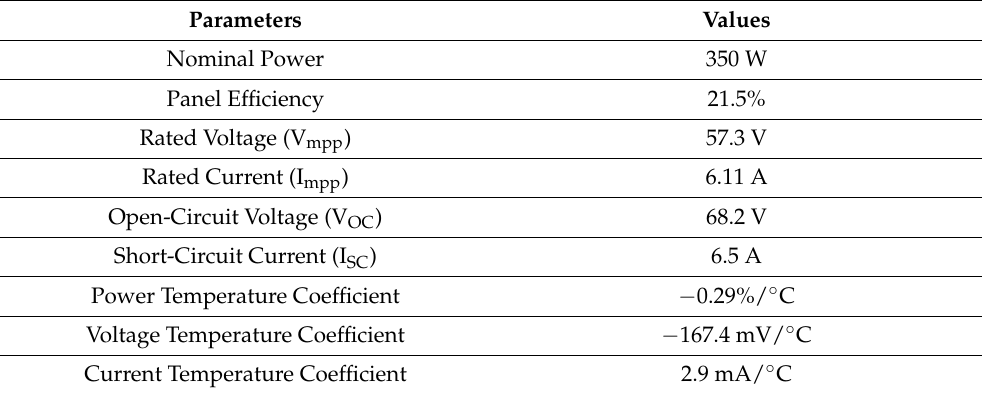
Figure 5. The PV installation site with a 0.99 MW PV installation located at latitude 8.4° and longitude 99.7° . Table 4. The X21-350-BLK solar panel specification .